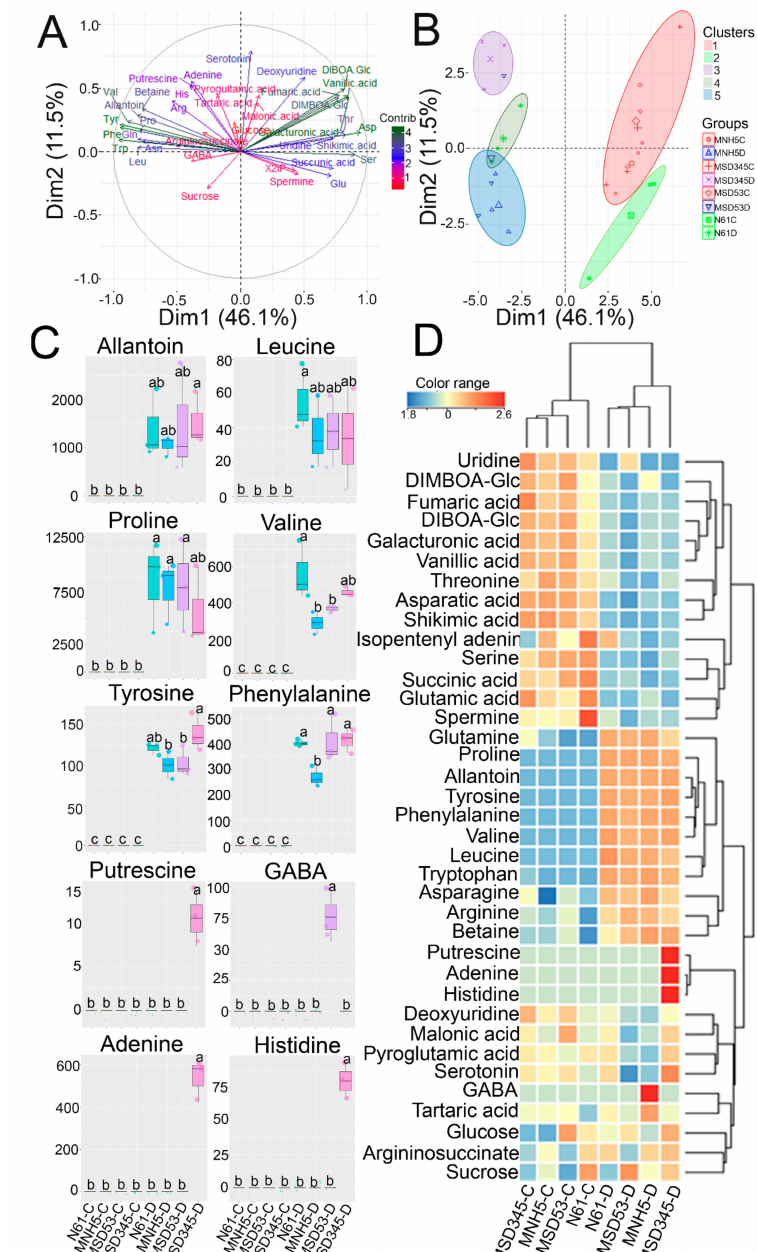
Figure 3. Principal component analysis (PCA) and accumulation of specific metabolites in the three multiple synthetic derivative lines (MSDLs) and their backcross parent, “Norin 61” (N61), under control and drought stress conditions. Dim1 and Dim2 refer to PC1 and PC2, respectively. ( A ) Loading plot of the metabolite variables showing increasing metabolite contributions from red to green. ( B ) Score plot showing conditional and genotypic separation due to di ff erences in metabolite profiles. ( C ) Drought-specific and MSDL-specific metabolite accumulations. Values marked with the same letter are not significantly di ff erent ( p < 0.05) between genotypes and conditions according to Tukey’s HSD test. ( D ) Clustered heatmap of metabolite levels in the MSDLs and N61 under control and drought conditions. The Z -score transformations of the mean metabolite concentrations were used to construct the heatmap. Accumulation rate: red, high; yellow, low; blue, very low. Data represent the mean ± standard deviation of three biological